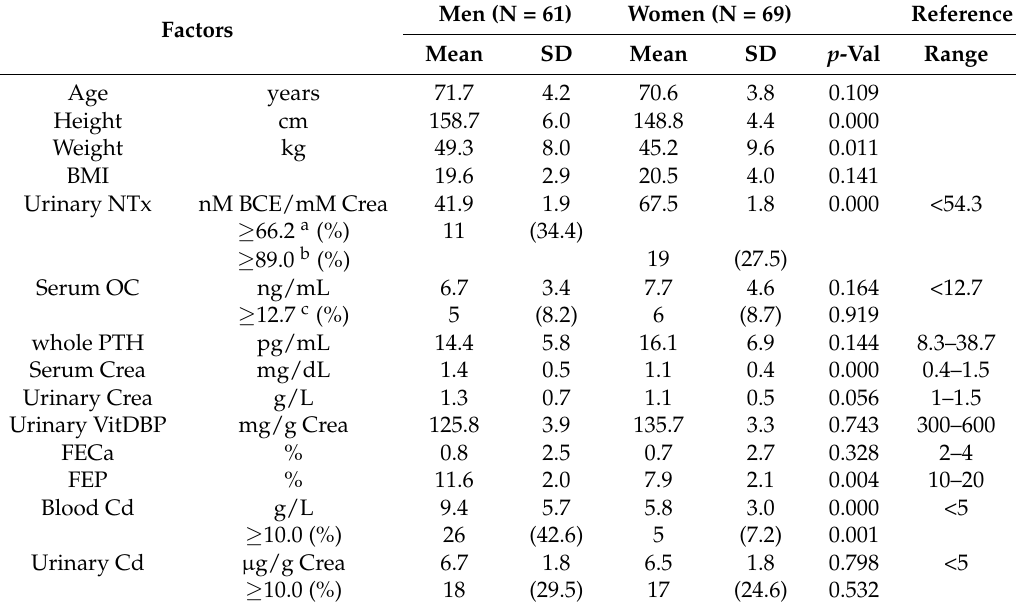
Table 1. Comparisons of factors related to bone metabolism and Cd exposure markers by gender. Men (N = 61) Women (N = 69) Reference Factors Mean SD Mean SD p -Val Range years